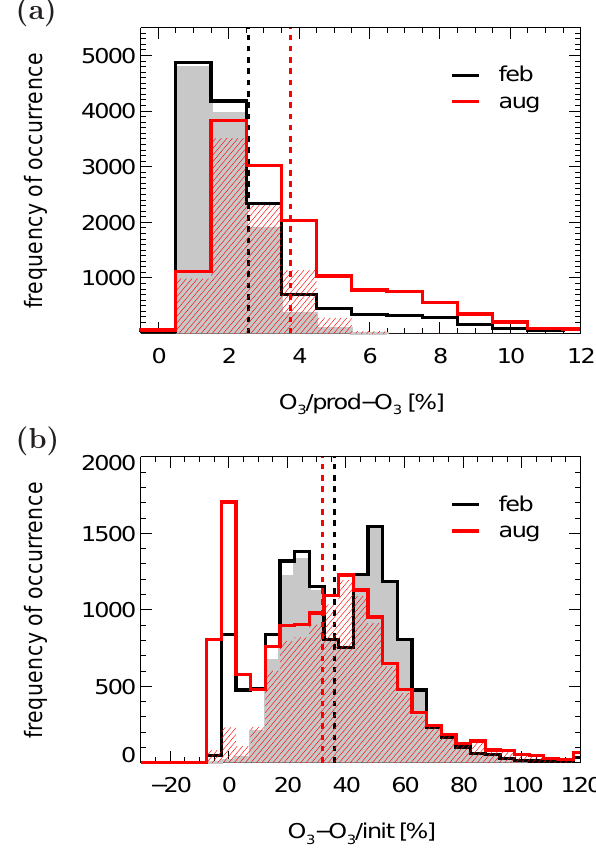
Fig. 9. (a) Effect of chemical ozone loss, calculated from the differ- ence between trajectory reconstructed ozone from photolytical pro- duction only (O 3 /prod) and from both photolytical production and HO x -loss, for February (black) and August (red), started at 400K (see text). Frequency of occurrence for TST trajectories only is shown as grey shaded/red dashed area for February/August. (b) Net effect of chemistry, calculated as difference between trajectory re- constructed and passively transported (initialisation, O 3 /init) ozone. The bin size is 1% and 5% in (a) and (b) , respectively. Black/red dashed lines show the means of the